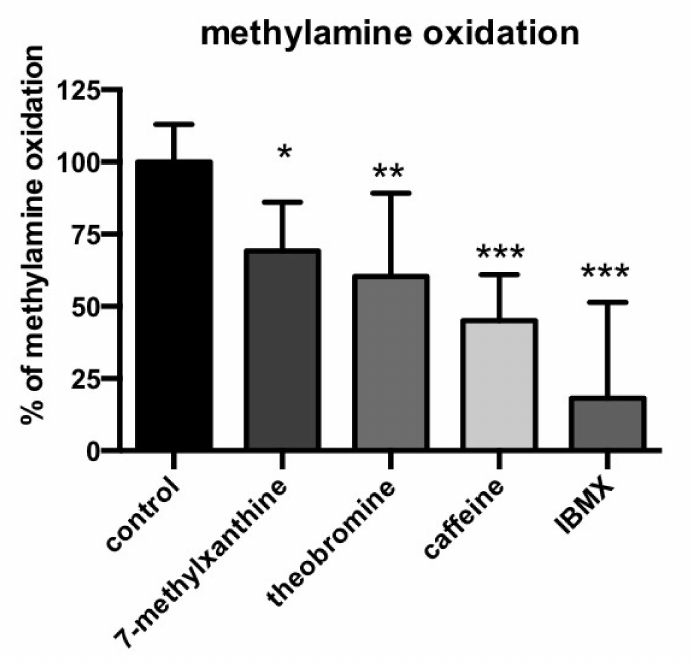
Figure 3. Inhibition by methylxanthines of the methylamine oxidation by human PrAO activity. The control condition consisted of the oxidation of 0.5 mM methylamine by hScAT homogenates during 30 min at 37 ◦ C and was set at 100% with the baseline of hydrogen peroxide release set at 0%. Each methylxanthine was added at 1 mM final and preincubated for 10 min before the addition of methylamine. Each column is the mean + SEM of seven individuals, each performed in